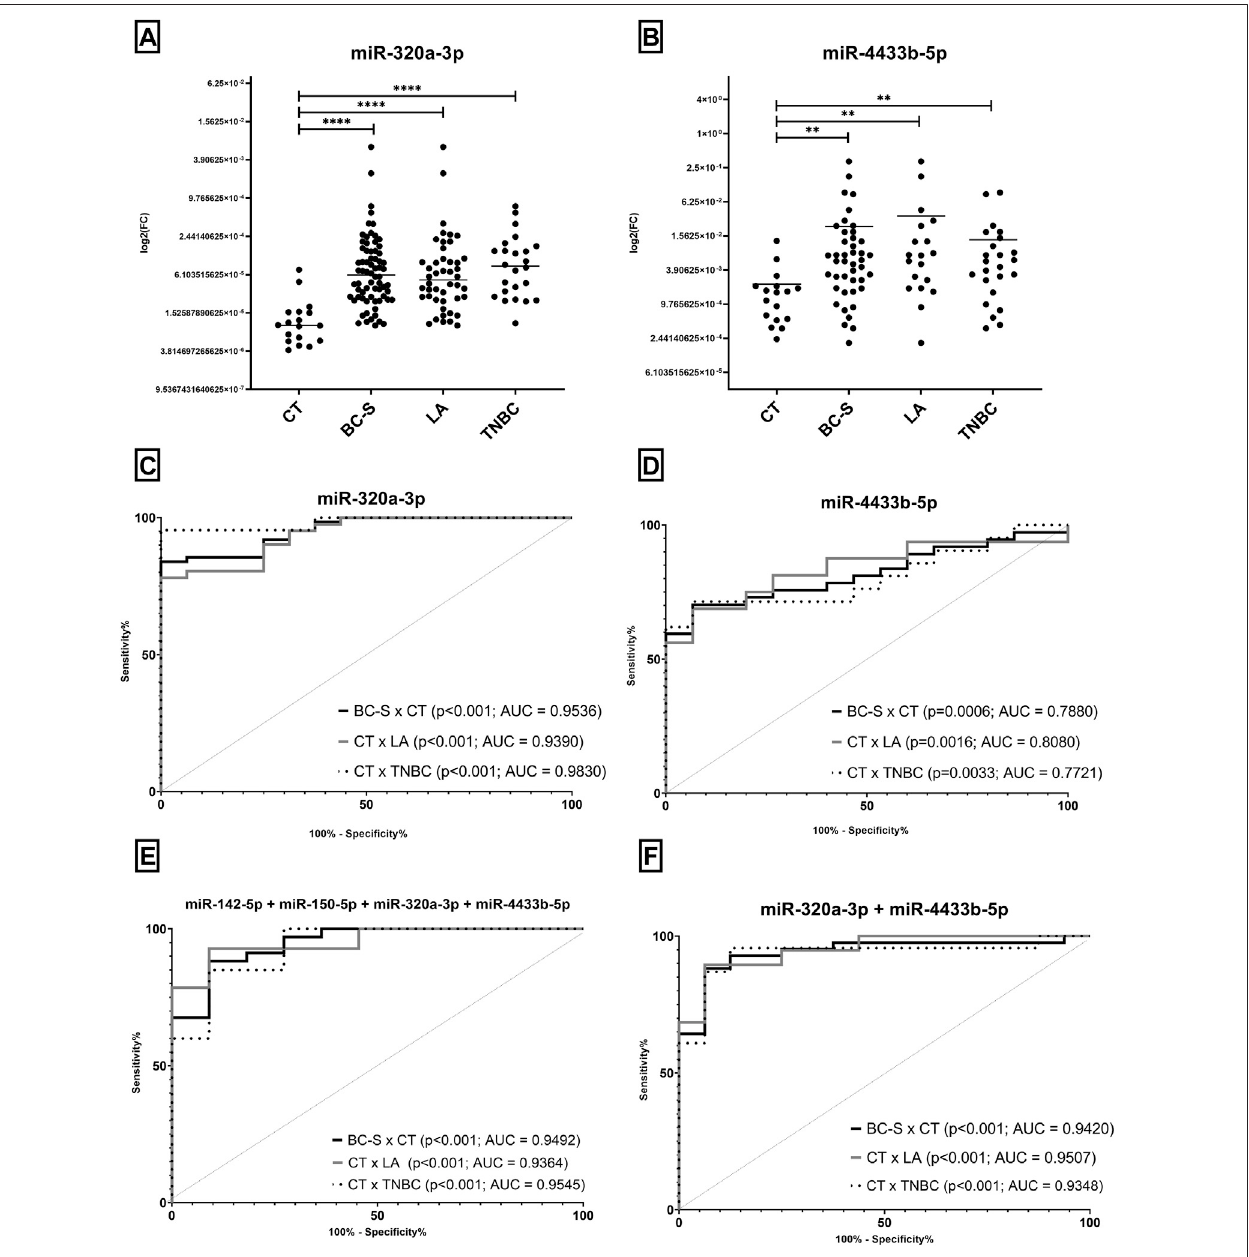
FIGURE 1 | Expression levels of miRNAs by RT-qPCR in serum samples and potential of cf-miRNAs to discriminate BC and subtypes (LA and TNBC) from CT. Expression levels of miRNAs (A) miR-320a-3p and (B) miR-4433b-5p in BC-S and subtypes (LA and TNBC) and CT. After outlier removal, each dot represents one sample.ROCcurvesforBC-SdiagnosisandprognosisinBraziliansamples (C – F) ,comparingBC-StoCT(black),CTtoLA(gray),andCTtoTNBC(dotted).ROCcurves were performed to evaluate miR-320a-3p (C) or miR-4433b-5p (D) individually (F) or in combination with all miRNAs in a completed panel (E) . ROC = receiver operating characteristic; AUC, area under the curve; CT, serum controls; BC-S, breast cancer serum samples; LA, luminal A; and TNBC, triple-negative breast cancer. (**) p = 0.001 and (****) p < 0.0001.